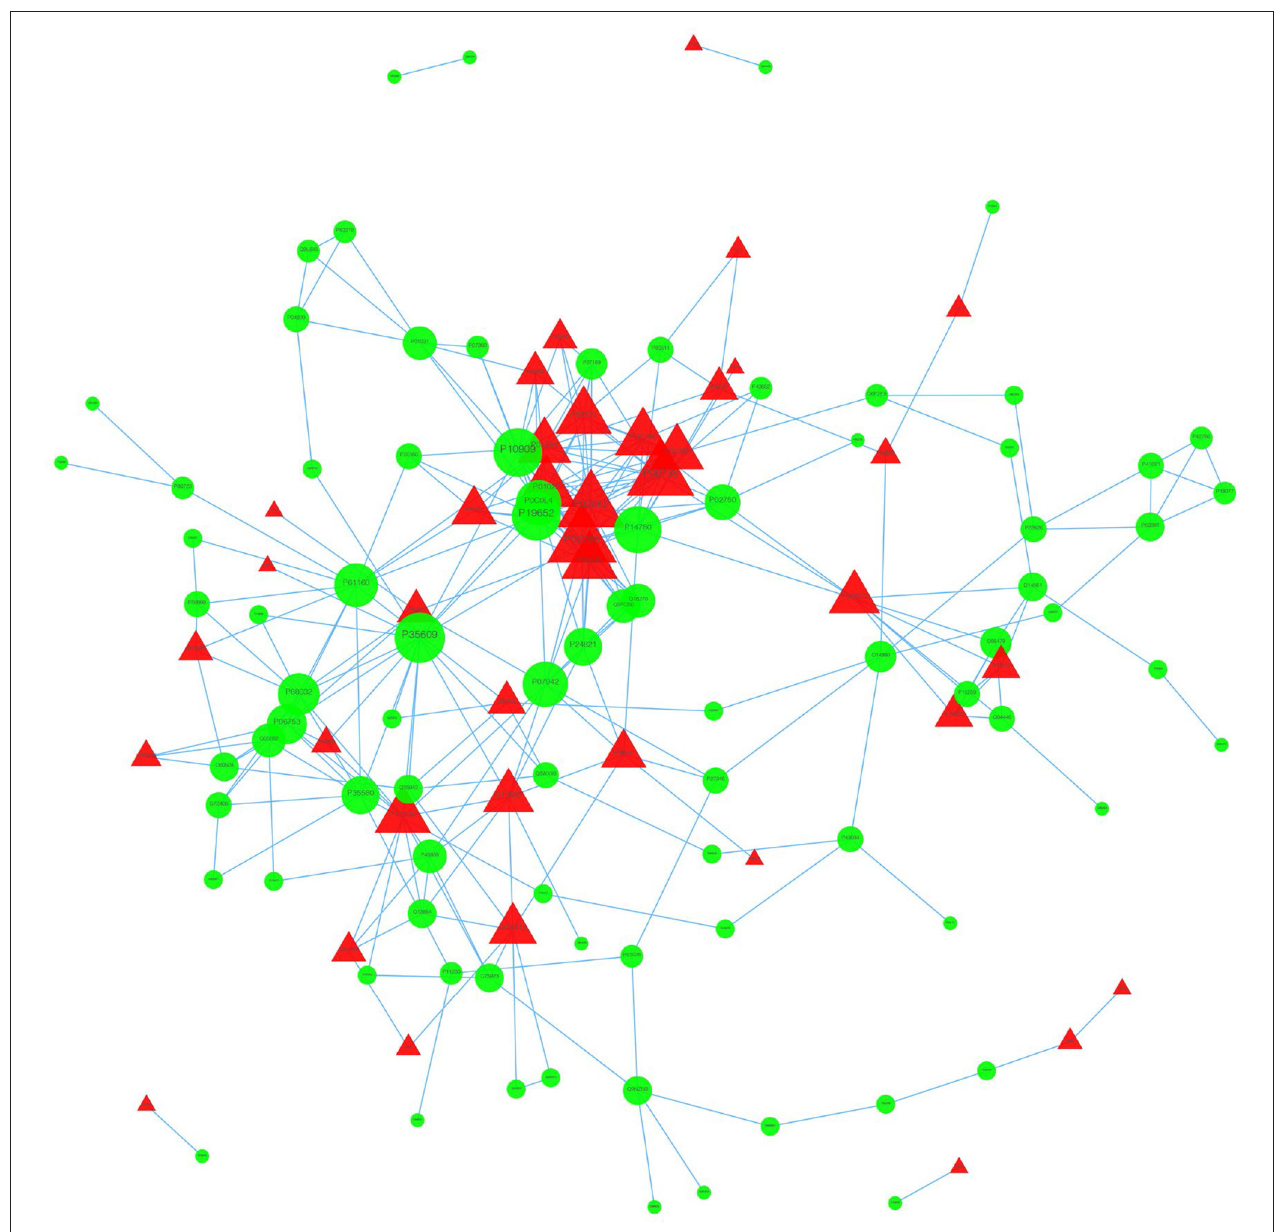
FIGURE 8 | Visualization of PPIs between the SDAVF-DV and STV. Visualization of PPIs for the top 300 proteins using STRING analysis. Red represents upregulated proteins, and green represents downregulated